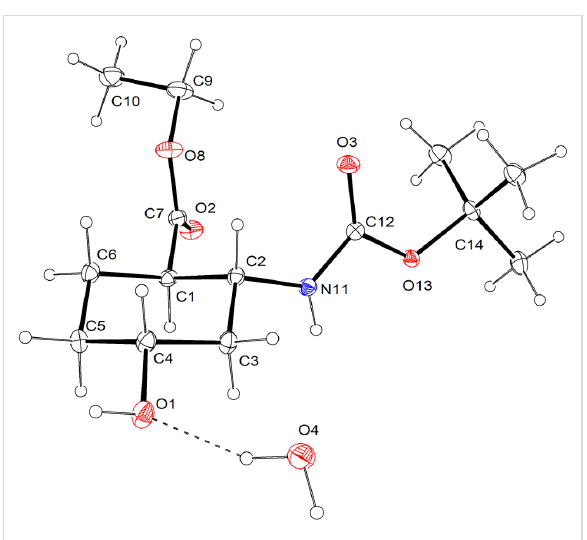
Figure 4: ORTEP diagram of hydroxylated amino ester 14 . The water molecule oxygen atom O4 is situated on the twofold axis with a popu- lation parameter of 0.6. Thermal ellipsoids have been drawn at the 20% probability